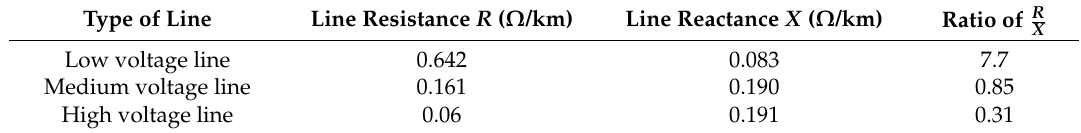
Table 1. Line parameters in microgrid [28,29].